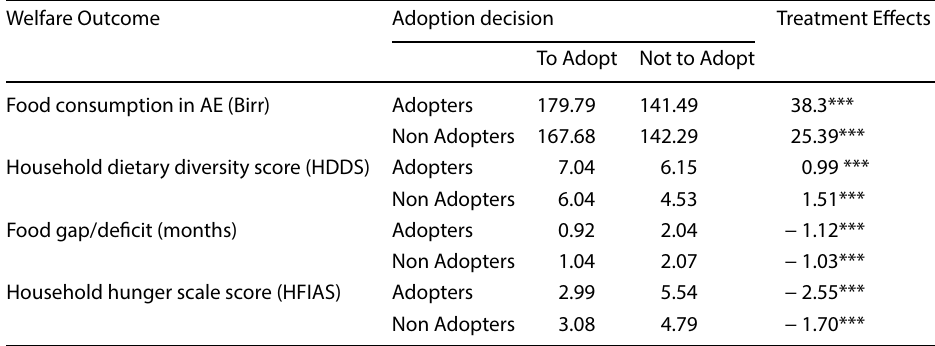
Table 5 Average treatment effects: endogenous switching regression model